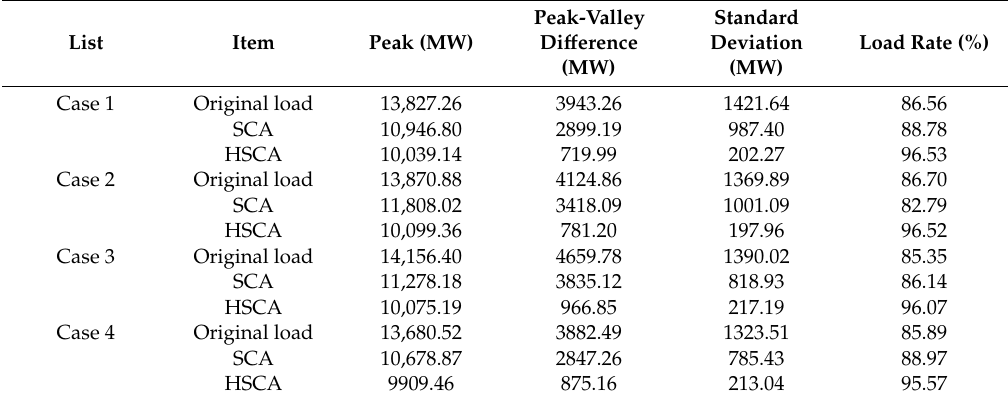
Table 12. Results obtained by different algorithms in 12 cases.